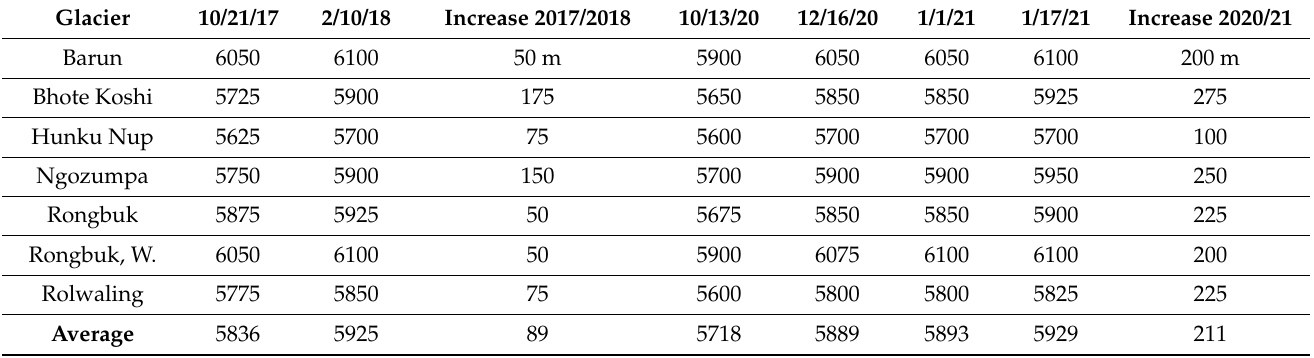
Table 1. Snow line elevation (meters above sea level) on selected glaciers from Landsat image observations indicating the increase both from October 2017 to February 2018 and from October 2020 to January 2021.